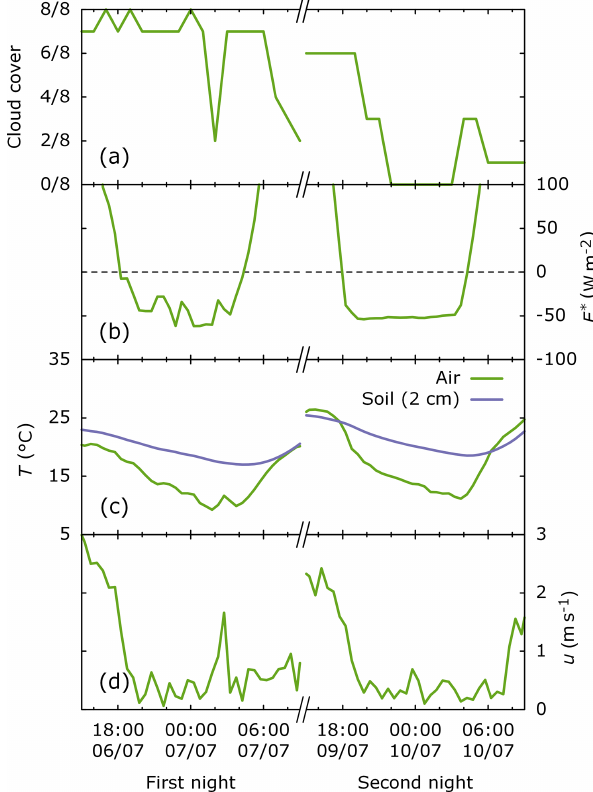
Figure 6. Meteorological conditions during the NBL soundings: (a) cloud cover, (b) net radiation E ∗ , (c) temperature T of air (2m height) and soil (2cm depth), and (d) horizontal wind speed u (3.5m height). Cloud cover was determined at MOHP, and all other observations were made directly at Fendt. Time is given in Coordinated Universal